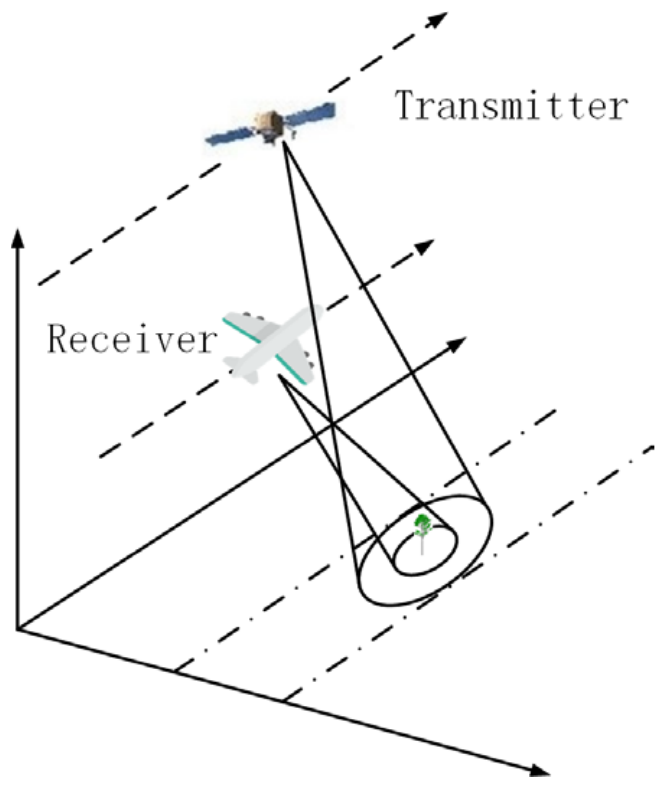
Figure 2. UAV robot observation configuration.